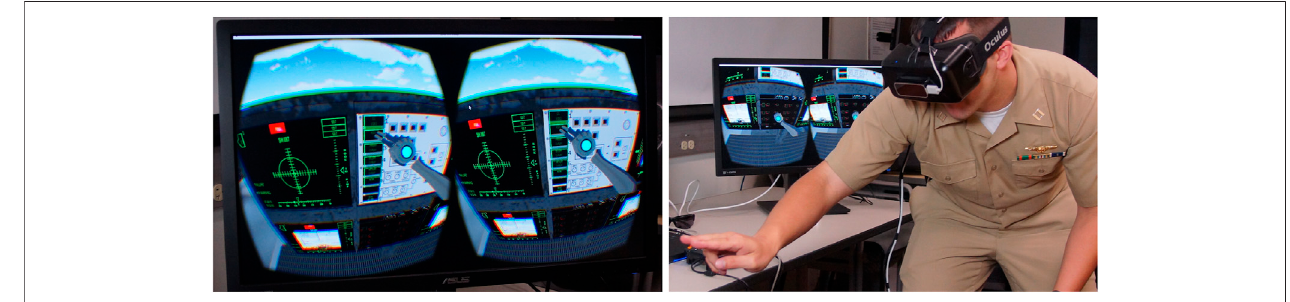
FIGURE 5 | A user demonstrates using the Landing Signal Of fi cer Display System for training. Image courtesy of Greunke and Sadagic (2016).